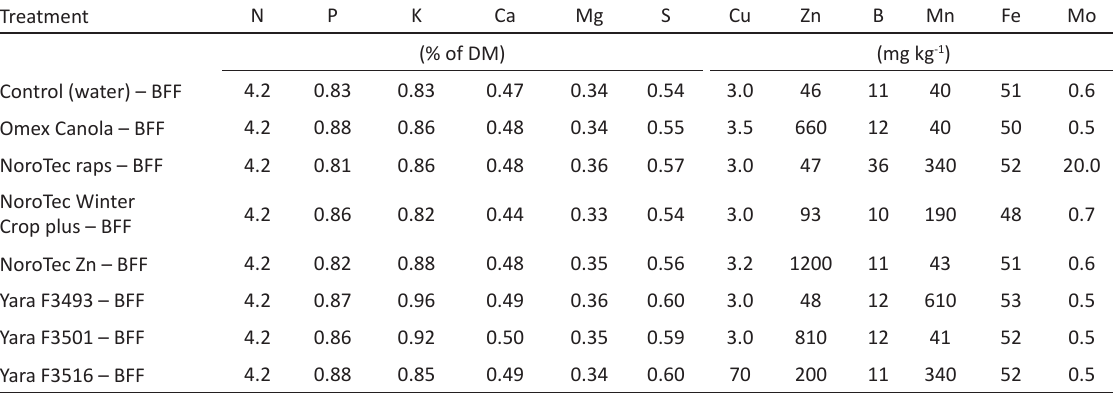
Table 4. Concentrations of mineral nutrients in seeds of spring oilseed rape treated with various seed treatment products without the application of binder, filler and Rovral (– BFF), that were used in vigour tests and field experiments 2017, n=1